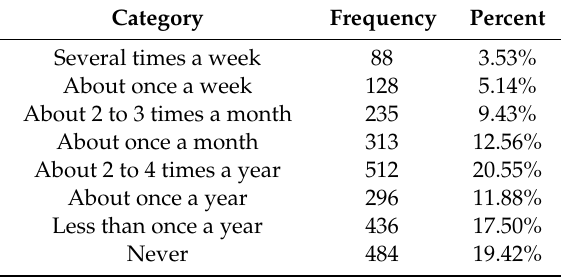
Table 2. Nightmare frequency ( n = 2492).